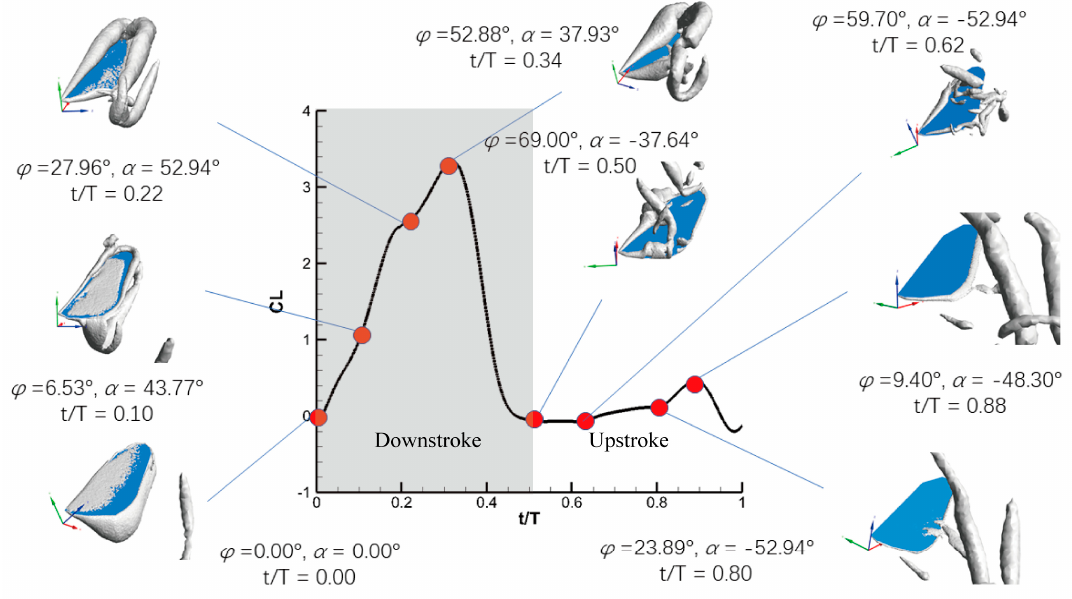
Figure 12. The lift force and iso-vorticity surface plots for 8%T PAM.